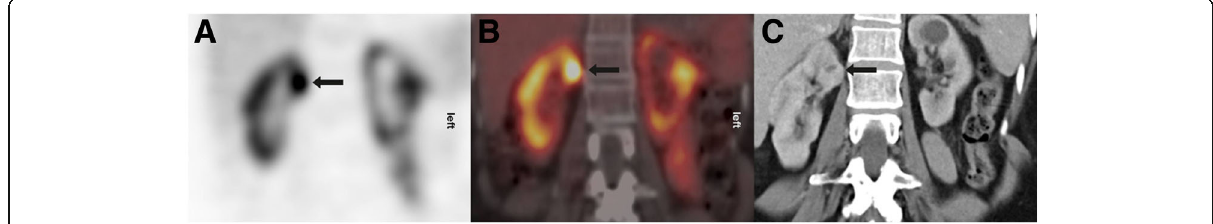
Fig. 1 The scintigraphic study ( a ) displays a coronal view of focal radioisotope uptake in the upper pole of right kidney ( arrow ). Anatomic correlation of the previous uptake ( c ) in the CT study, coronal view-venous phase. The coronal SPECT/CT fusion image ( b ) with sestamibi uptake in the same solid renal neoplasm (24 mm in maximum diameter) of the right kidney. This was subsequently diagnosed as renal oncocytoma on histopathological